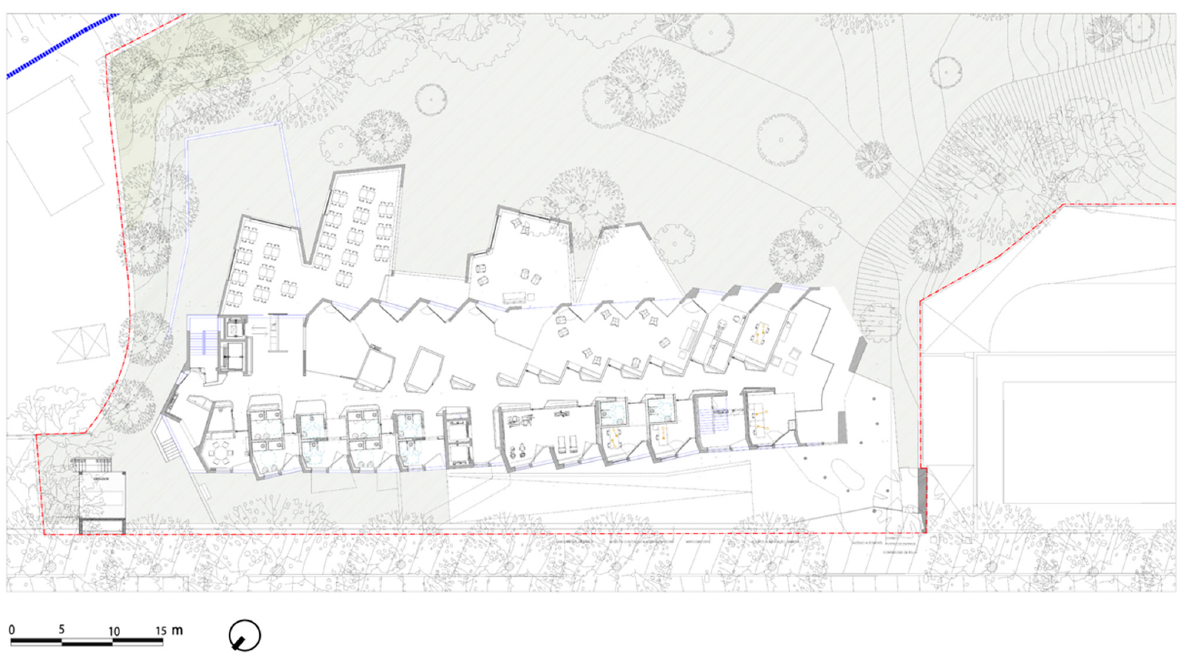
Figure 26. Porto. Ground- fl oor plan.